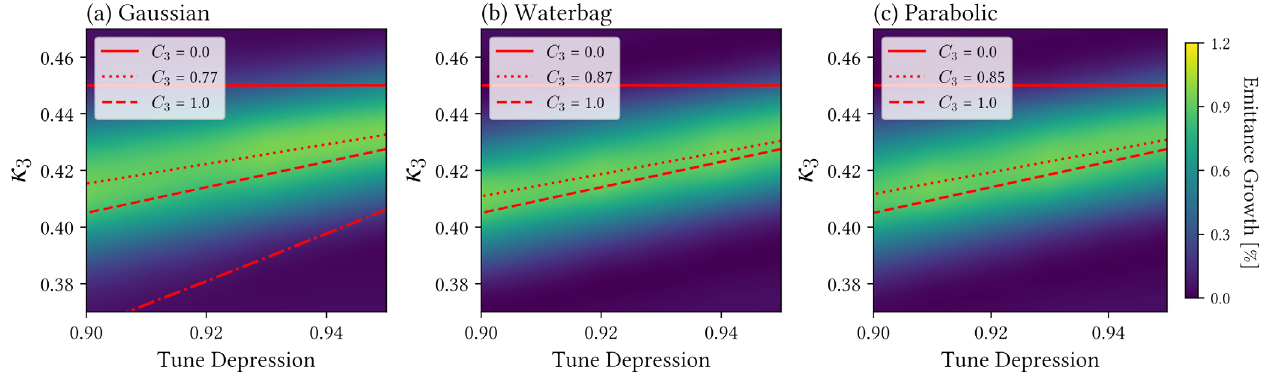
FIG. 13. Emittance-growth chart obtained from W ARP simulations with the sextupole driving perturbation on. Except for the order of the external perturbing field, all numerical conditions are the same as employed in Fig. 12. The perturbation amplitude is set at 0.4% of the focusing field ’ s. The dotted line is the location of the stop-band peak fitted by Eq. (14) with C 3 ¼ 0 . 77 for Gaussian, C 3 ¼ 0 . 87 for waterbag, and C 3 ¼ 0 . 85 for parabolic.